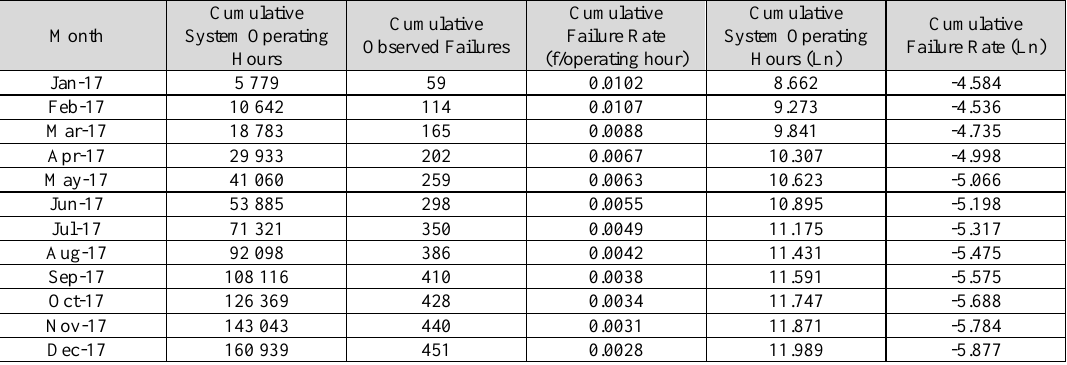
Table 3. Logarithms of cumulative system operating hours and cumulative failure rate utilizing Duane